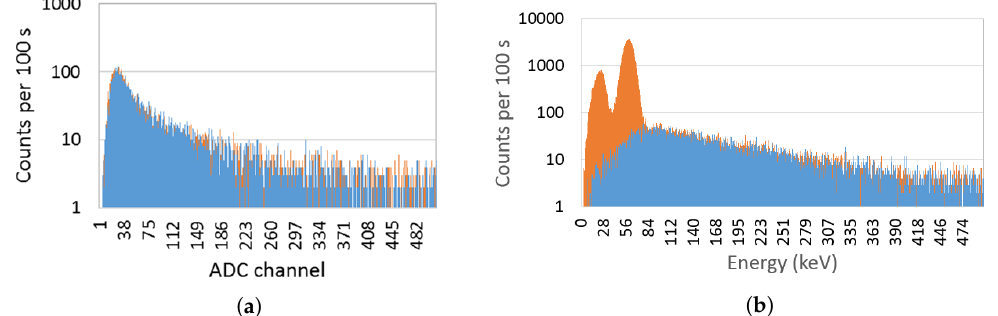
Figure 14. Gamma-ray spectra for a 22 kBq 241 Am source next to the detector window (orange color) and background (blue color) obtained with the: ( a ) EJ-200 scintillator (total counts: 6269 ± 79; background counts: 6287 ± 79). ( b ) CsI(Tl) scintillator (total counts: 112,202 ± 335; background counts: 26,038 ± 161).